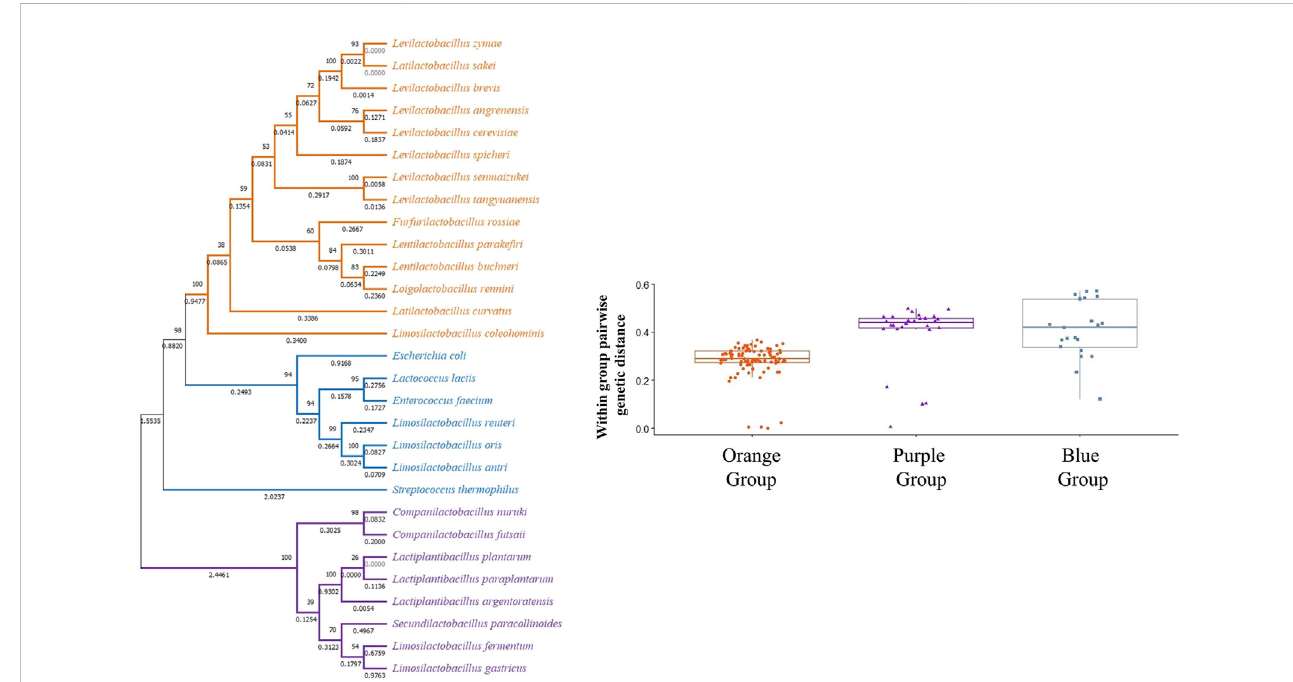
FIGURE 5 Phylogenetic tree based on transporter (gadC and yjeM) gene sequences from 29 bacterial species. The tree was constructed with MEGA-X using the Maximum Likelihood method and General Time Reversible (GTR) model. One thousand replicates were used to generate the bootstrap consensus tree. A discrete Gamma (G) distribution was used for evolutionary rate variations across sites. Numbers on the nodes show the bootstrap support, numbers on the branches show substitutions per site. Orange color represents species where GAD pathway genes are organized in an operon structure. Purple color represents species without an operon structure, and blue color represents species with a small operon structure consisting of only a transporter and a GAD